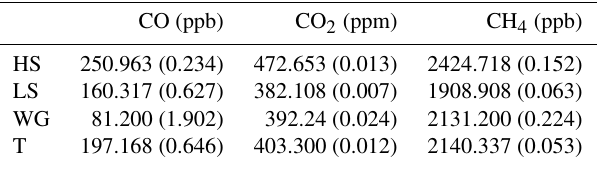
Table 1. Assigned (laboratory-calibrated) dry mole fractions of CO, CO 2 , and CH 4 in HS, LS, WG, and T calibration gas standards. Standard errors (1 σ ) are given in